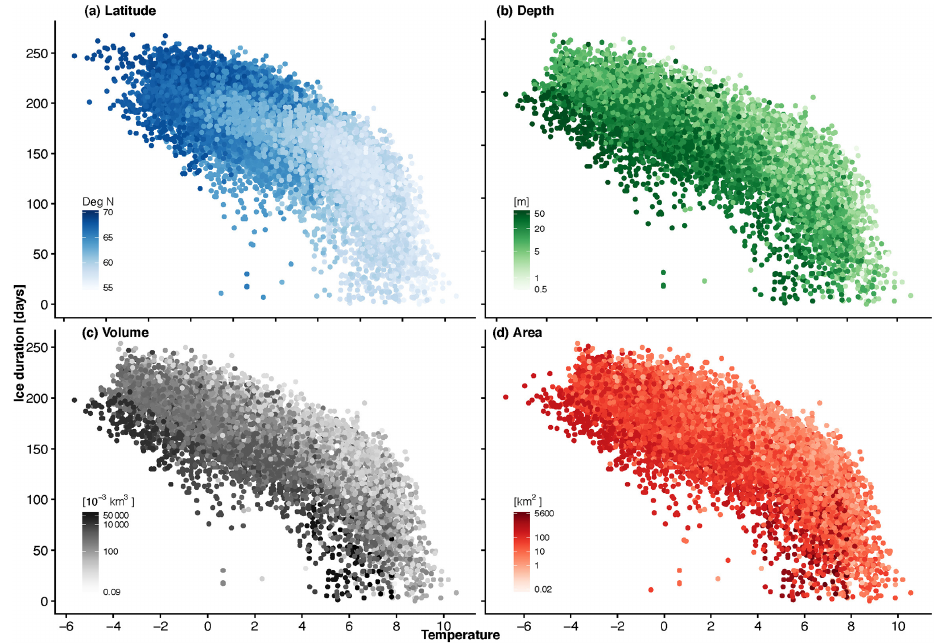
Figure 5. Ice duration (days) versus mean annual air temperature (September–August) (in degrees Celsius). Colors indicate the water body